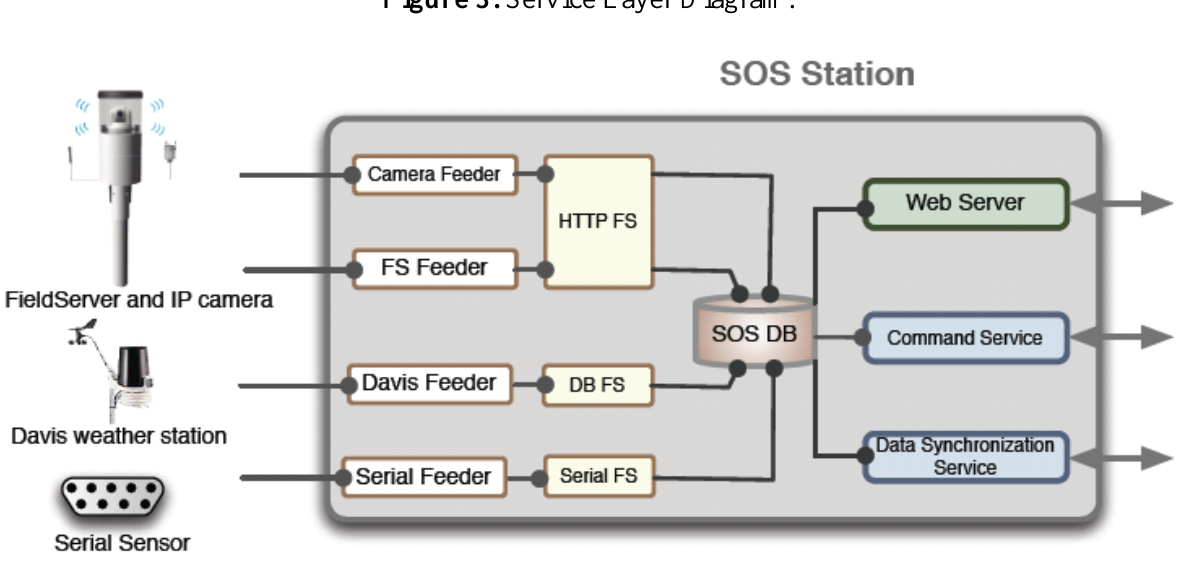
Figure 3. Service Layer